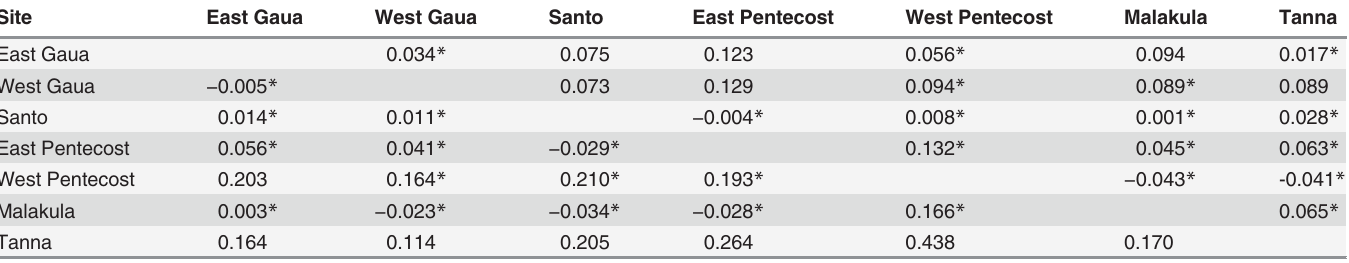
Table 4. Pairwise F ST genetic distances based on msp1 (lower triangle) and csp (upper triangle) haplotype frequencies in P . vivax from seven sites in Vanuatu. Site